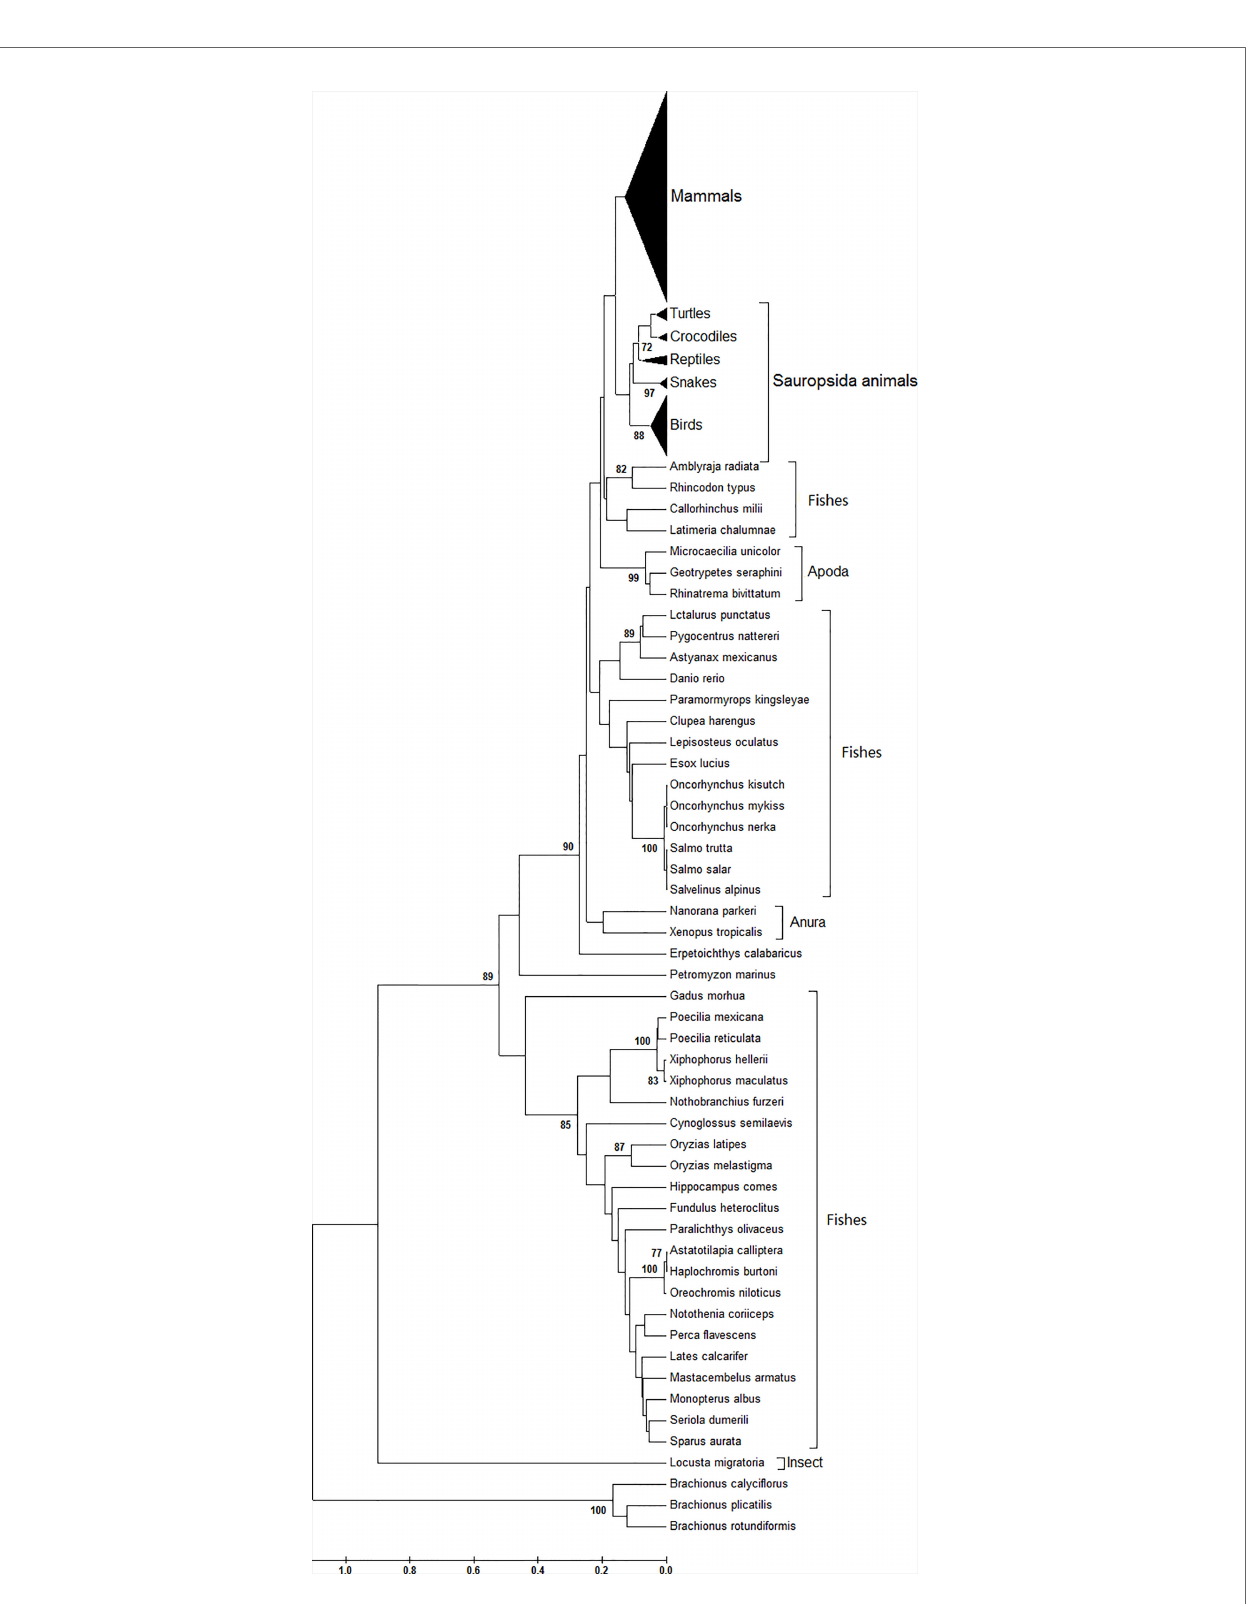
Frontiers in Cellular and Infection Microbiology |